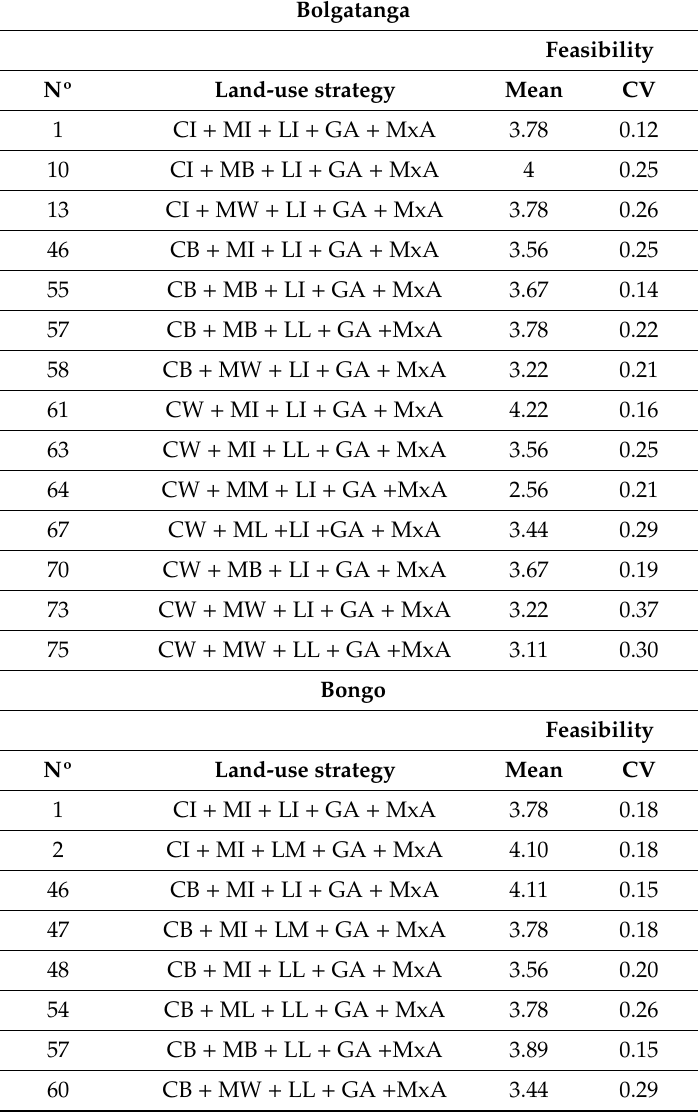
Table 2. The feasibility of best land-use strategies in Bolgatanga and Bongo. Mean values and the coe ffi cient of variation (CV) of a Likert-scale survey result (from 0 = unrealistic to 5 = very likely) are used for the identification of most feasible land-use strategies. Bolgatanga